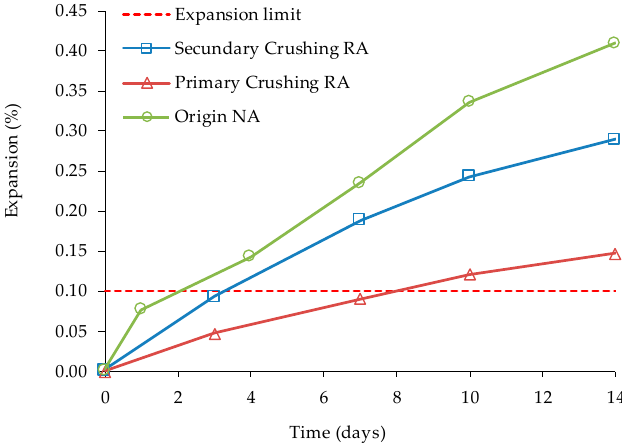
Figure 2. Expansion of RA from primary and secondary crushing in the ASTM C 1260 test, adapted from [73].